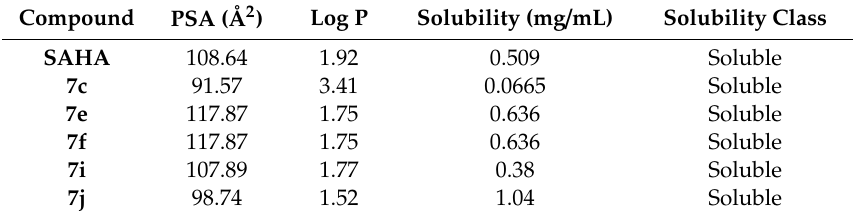
Table 5. Physicochemical parameter values of compounds SAHA and 7a – k . Compound